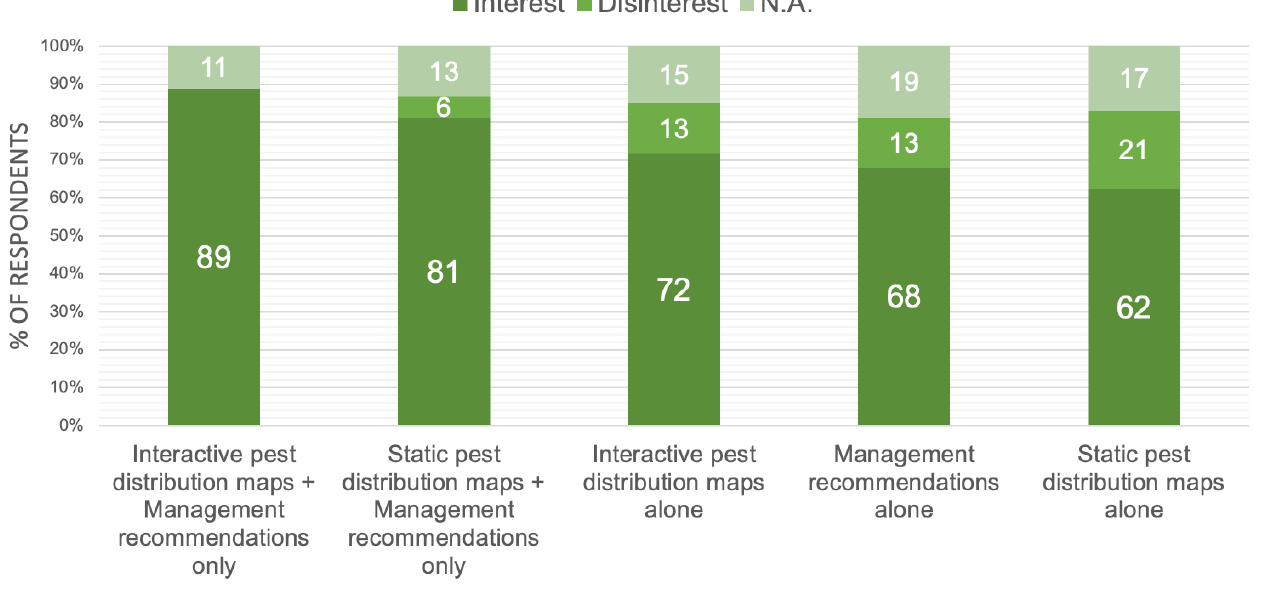
Figure 4. Percentages of respondents reporting which type of FAW prediction product they would be interested in when presented with the choices of static distribution maps, interactive distribution maps or management recommendations, or a combination of these.